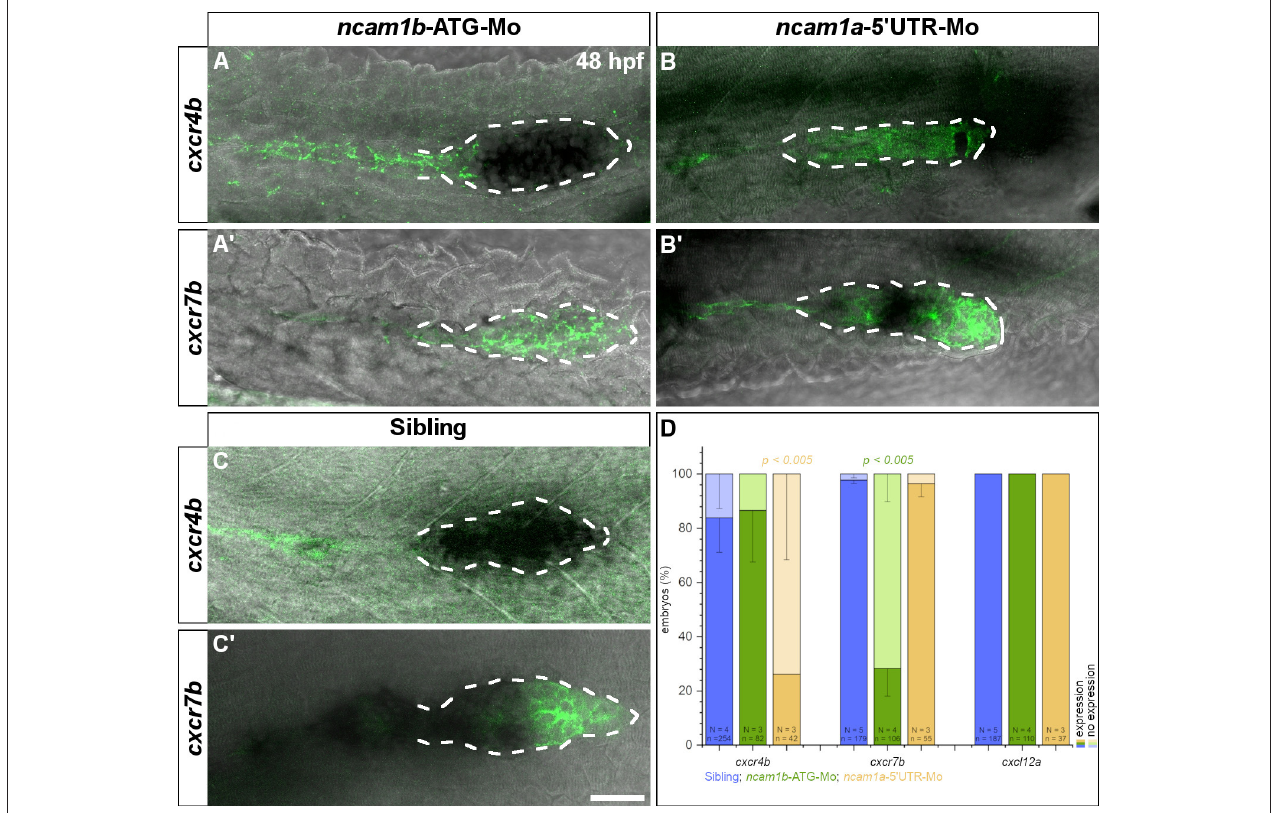
FIGURE 6 | Expression of chemokine receptor cxcr7b is affected by knockdown of ncam1b . Tg(ClaudinB::lynGFP) embryos (48 hpf) were immunostained for GFP (green). In situ hybridizations of probes detecting cxcr4b (complete PrimI) and cxcr7b (Trailing-Zone), were visualized by NBT/BCIP staining. Primordia outlines were surrounded with a dotted line for better visibility. ( A,A ′ ) Expression of cxcr4b is not affected in ncam1b -morphants, whereas expression of cxcr7b is markedly reduced. ( B,B ′ ) In ncam1a -morphants cxcr7b is present, whereas cxcr4b expression is reduced. ( C,C ′ ) In siblings, cxcr7b is robustly expressed in the Trailing-Zone. ( D ) Drastically reduced cxcr7b expression after knockdown of ncam1b . Error bars represent standard deviation. X 2 -test with ns = p ≥ 0.05. Scale bar 20 µ